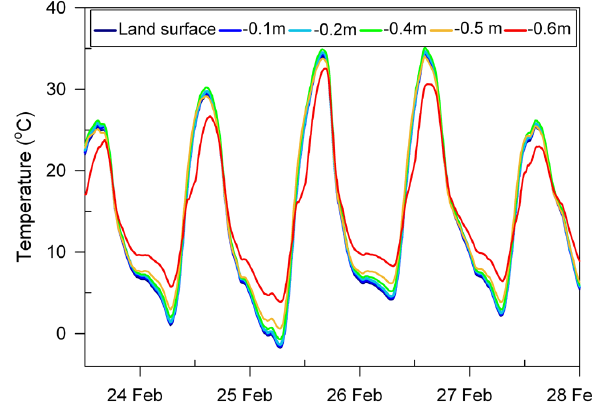
Fig. 7. Daily fluctuations in the temperature profile inside desicca- tion cracks at the study site. Each line represents a different tem- perature sensor and its depth, relative to the land surface. Note the unstable conditions (cold air above warm air) that develop in the cracks every